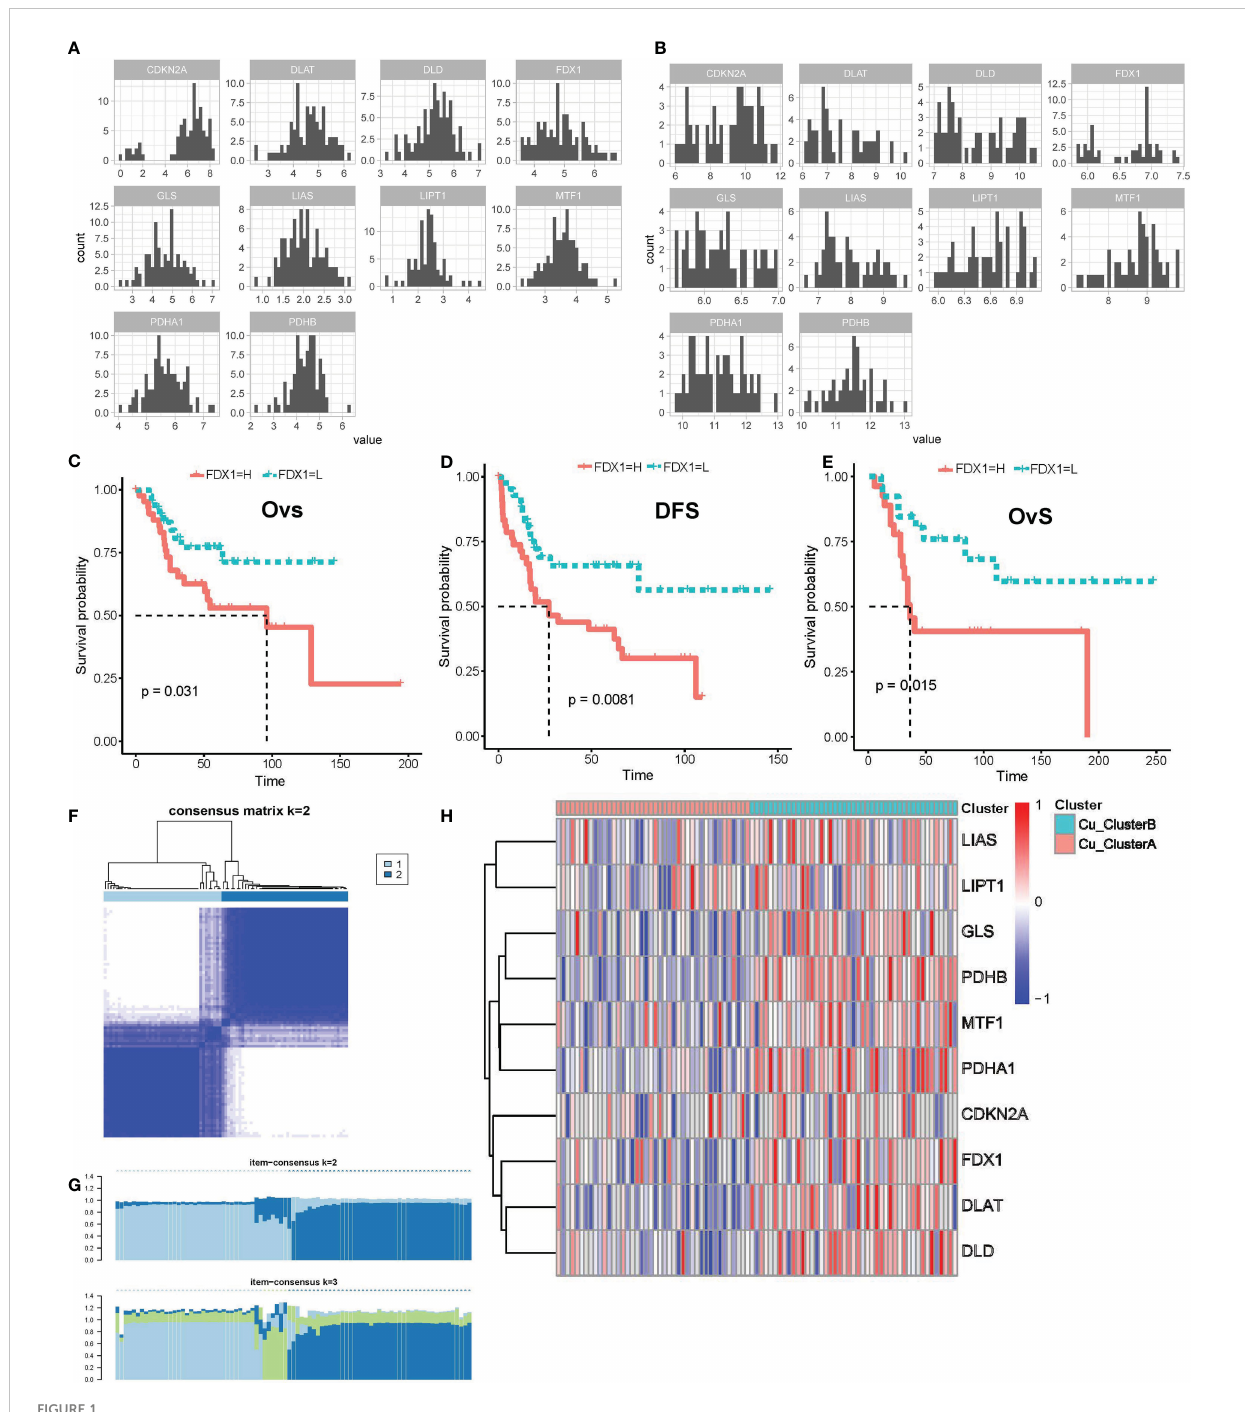
FIGURE 1 Cuproptosis regulatory genes were expressed in distinct patterns in OS samples. (A, B) Expression distributions of cuproptosis regulatory genes in TARGET_OS (A) and GSE21257 (B) datasets. (C – E) K-M survival curve for FDX1 high- and low- expression subgroups in TARGET_OS (C, D) and GSE21257 datasets (E) , Ovs, overall survival; DFS, disease-free survival. (F, G) Results of consensus clustering based on the expression of cuproptosis regulatory genes, (F) Consensus heatmap, (G) Item-Consensus plot. (H) Heatmap shows the expression of cuproptosis genes in distinct